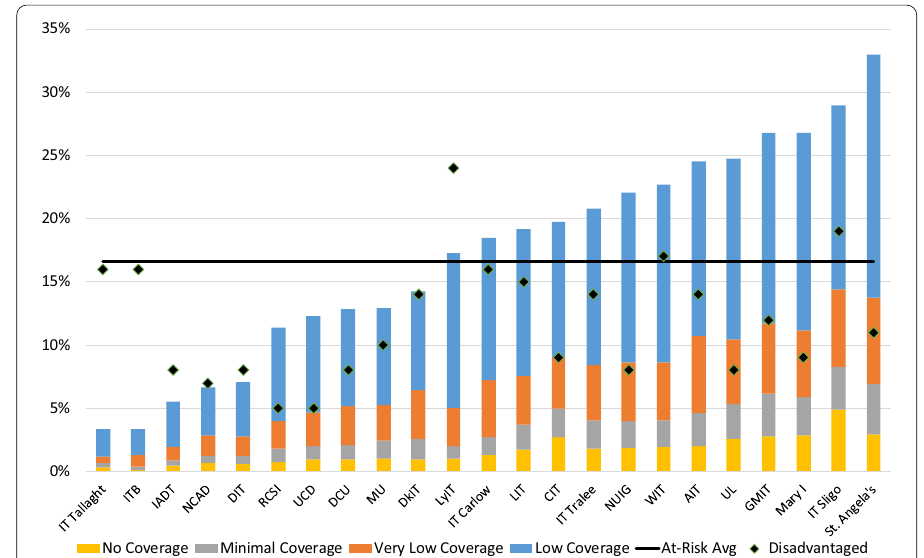
Fig. 4 Proportion of enrolments from at-risk electoral divisions by HEI. Source: Analysis of data from HEA, GeoDirectory, and National Broadband